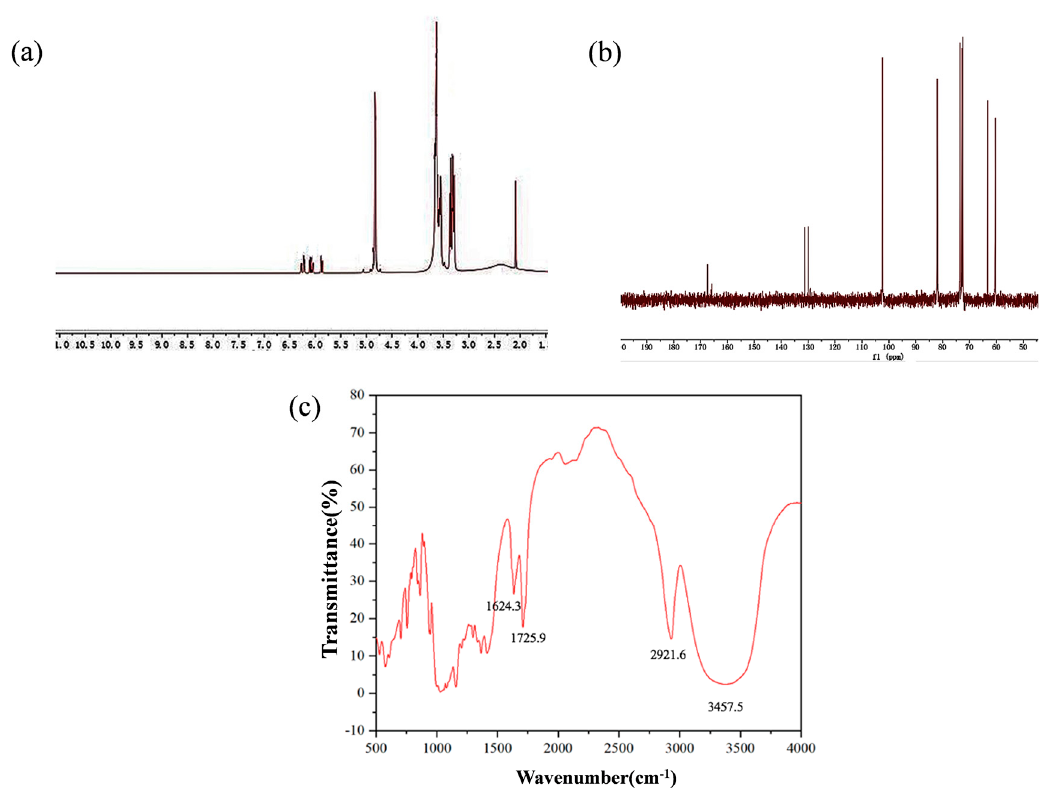
Figure 2. ( a ) 1 H NMR; ( b ) 13 C NMR; ( c ) FTIR of A −β− CD.